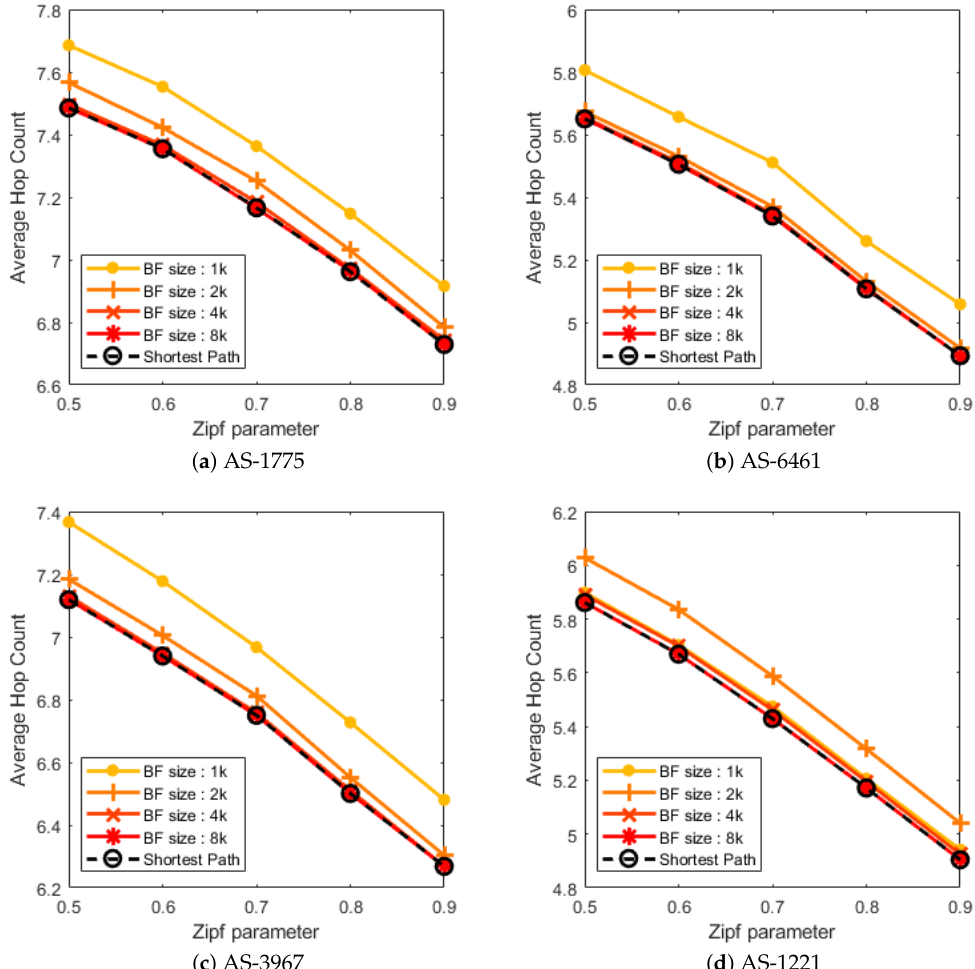
Figure 6. The average number of hop count under the various sizes of Bloom filters. As the size of Bloom filters grows, the data retrieval is performed along the optimal path.